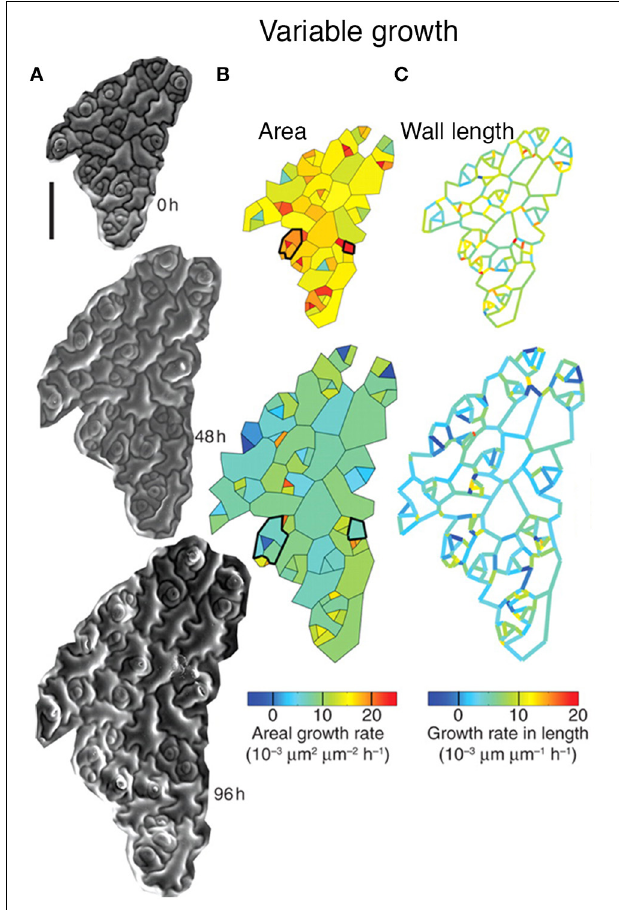
FIGURE 3 | Leaf epidermal cells exhibit growth variability. Cellular growth heterogeneity is apparent from (A) serial scanning electron micrographs (SEMs) of a growing Arabidopsis leaf over 96h. The analysis columns show the (B) areal growth rate and (C) growth rate in length. Cells that change their areal growth rate in time are outlined in black. Reprinted from Elsner et al. (2012) with permission from Oxford University